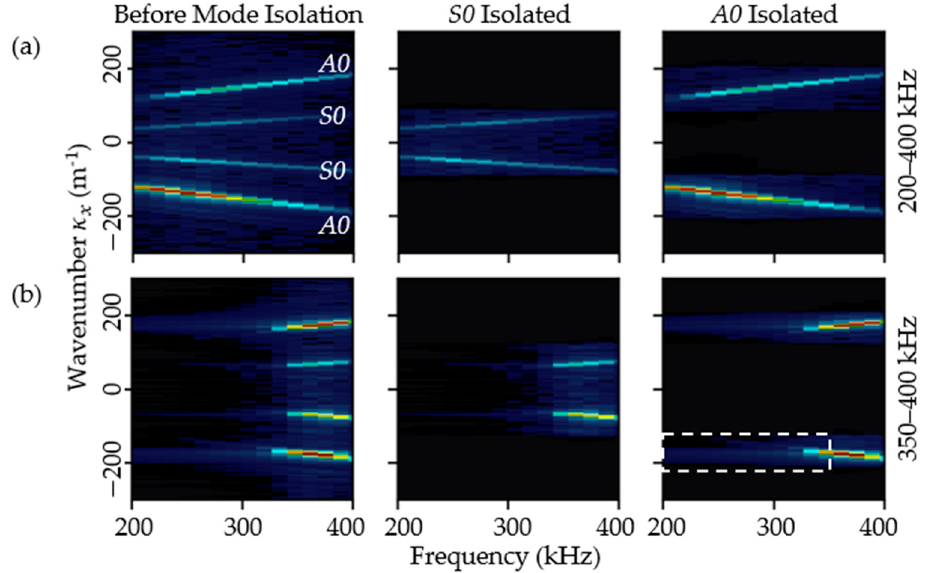
Figure 8. Wavenumber-frequency spectrums at 𝜅 (cid:3052) = 0 for wave fi eld data of ( a ) 200–400 kHz and ( b ) 350–400 kHz frequency bands. ( b ) 350–400 kHz frequency